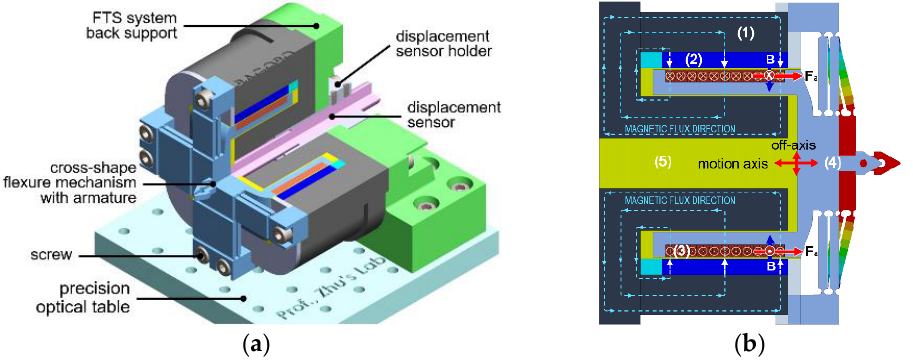
Figure 1. Mechanical structure of the voice coil motor (VCM) actuated fast tool servo (FTS) system, ( a ) the zonal-sectional view and ( b ) the cross-section view of the assembled structure, where (1) stator, (2) permanent magnet, (3) coil, (4) mover, and (5) air-part including air-gaps (yellow part).